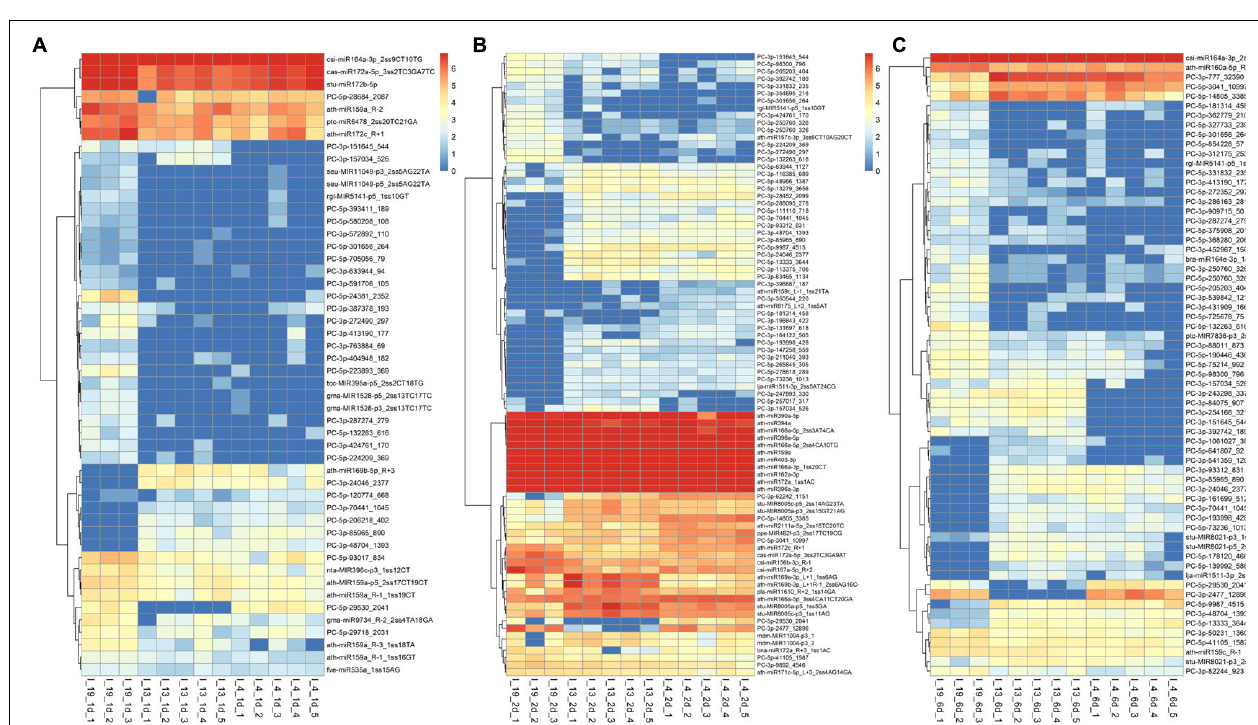
Figure 3 and the control samples in Supplementary Figure 2 .